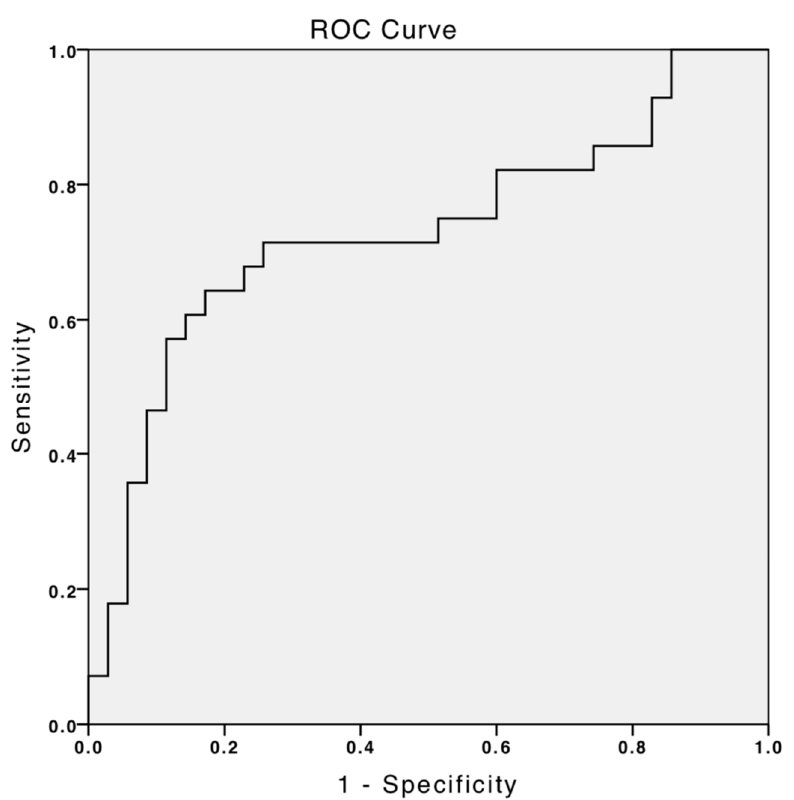
Figure 2. A receiver operating characteristic (ROC) curve was drawn based on the prediction equa- tion for the treatment outcome of a tongue-beaded OA. The area under the ROC (AUC) equals 0.729, indicating an acceptable discrimination threshold.